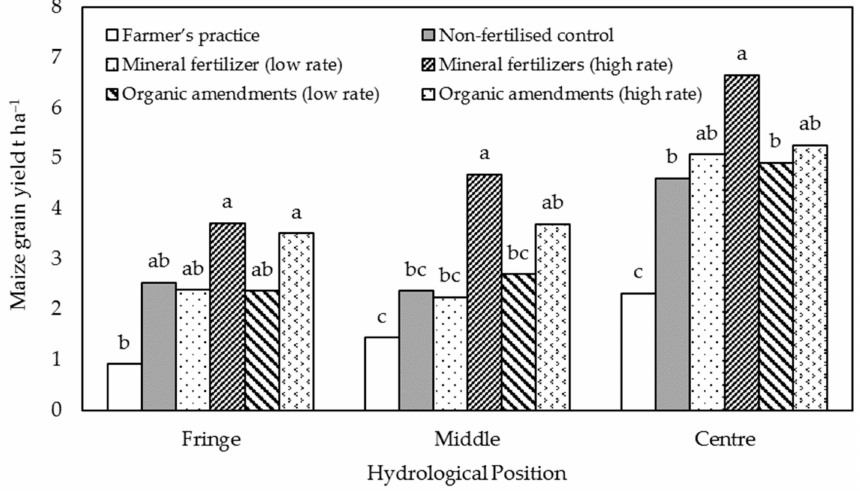
Figure 5. Grain yield of maize (t ha − 1 ) at three hydrological positions and under di ff erent crop management options at an inland valley in